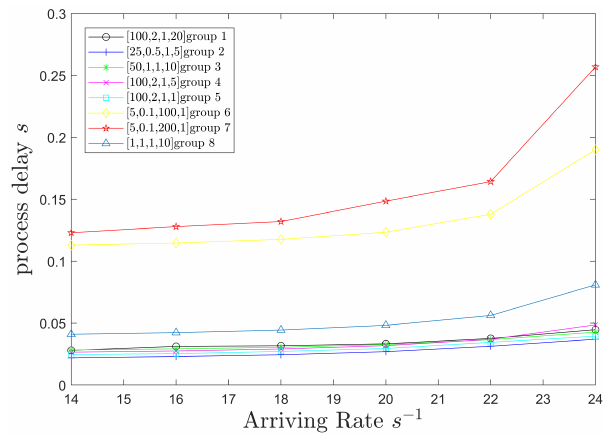
Figure 7. The relationship between t process and arrival rate λ